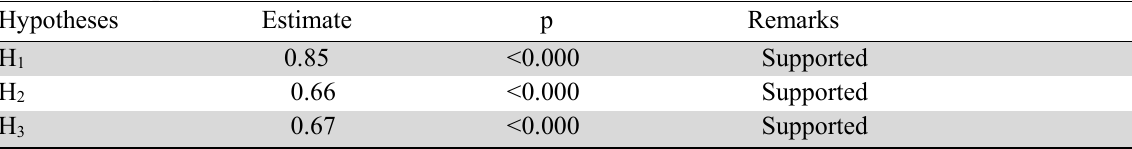
Standardized path